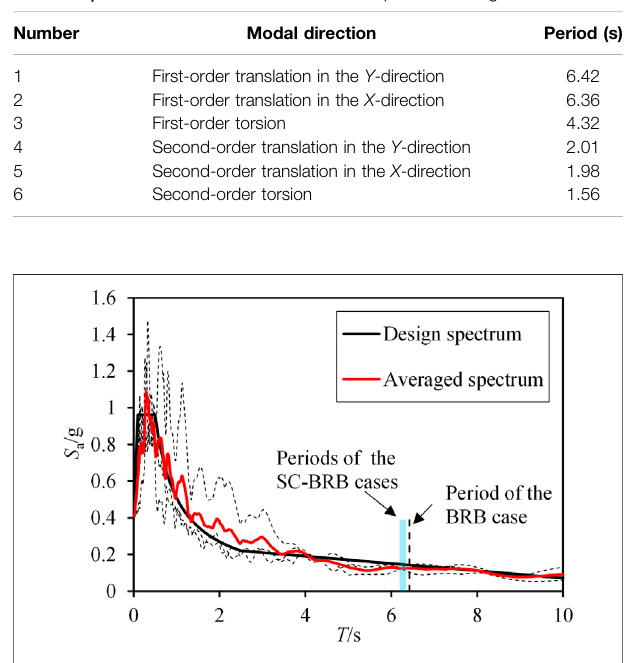
FIGURE 5 | Comparison between design spectrum and response